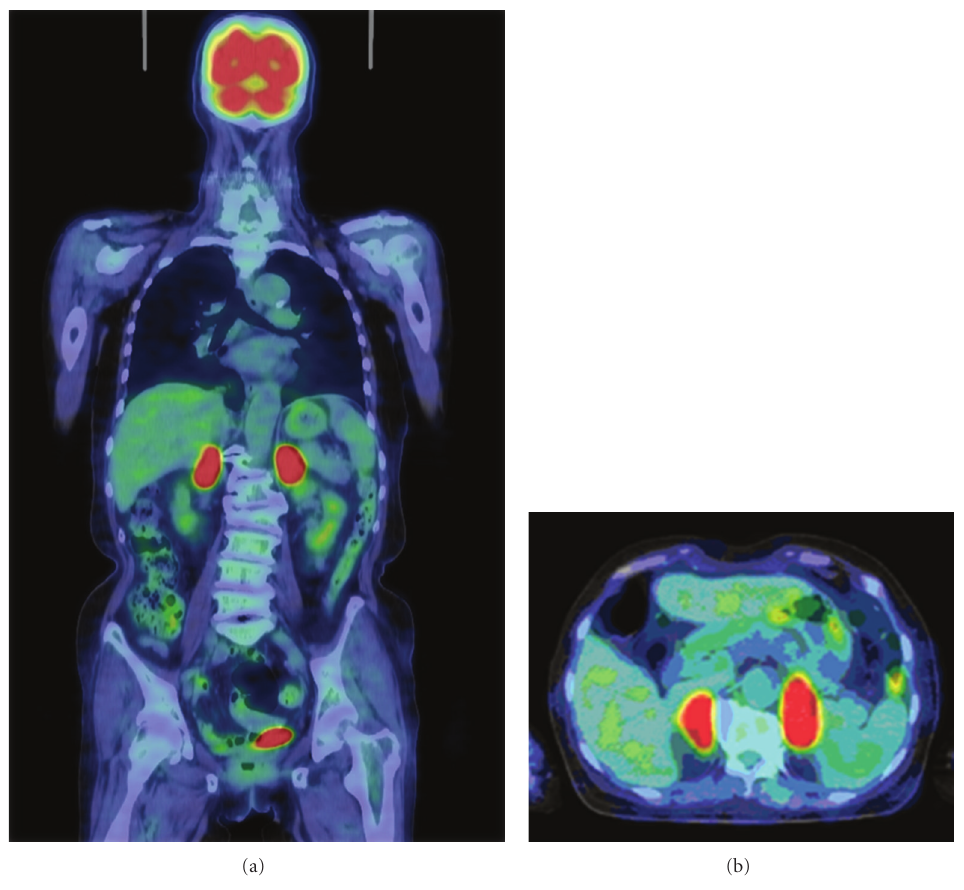
Figure 3: FDG-PET image showing an exclusive strong uptake in both adrenal glands: (a) coronal section; (b) horizontal section.